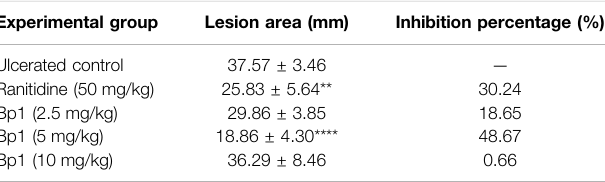
TABLE3| EffectofpretreatmentwithBp1(2.5,5,and10 mg/kg)inthelesionarea and percent inhibition in the ethanol-induced model. Experimental group